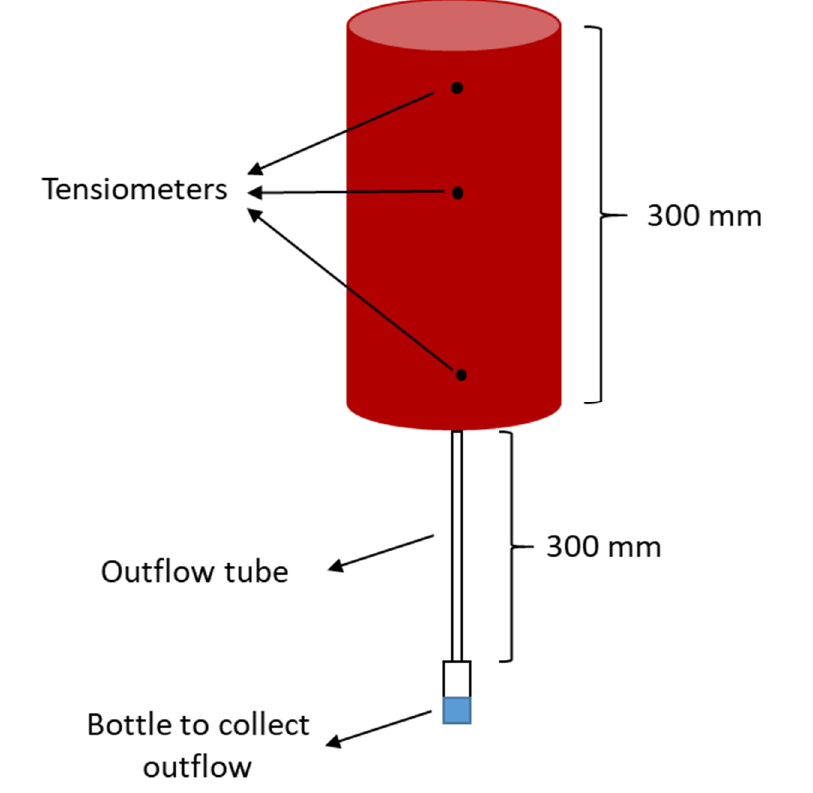
Figure 1. Schematic model of column study.